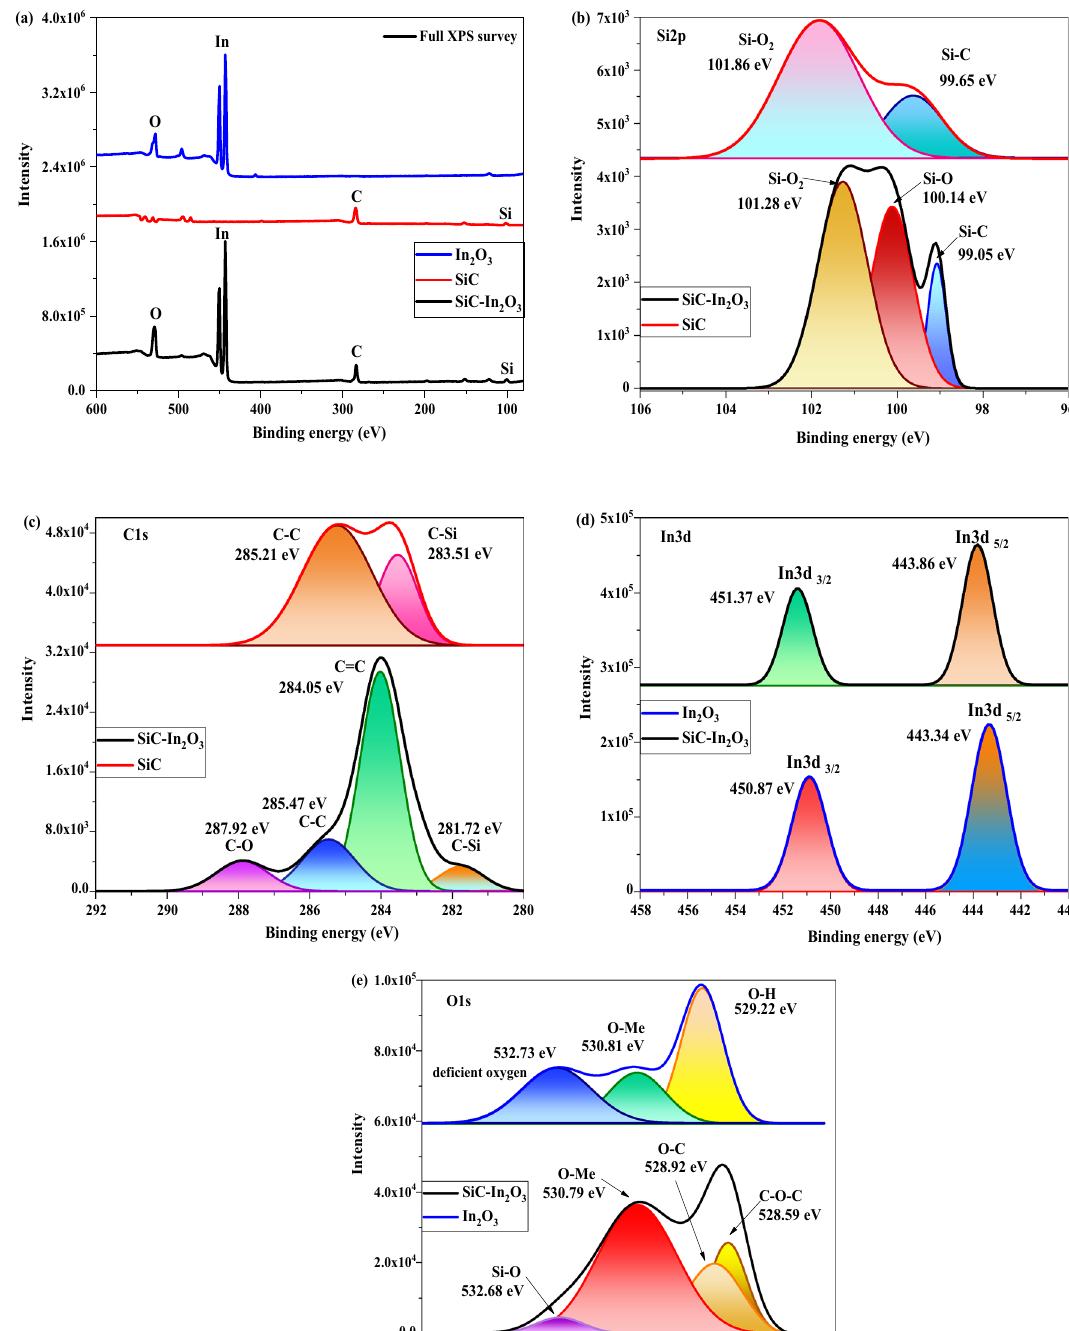
Figure 8. Full XPS surveys of the β-SiC, In 2 O 3 and β-SiC-In 2 O 3 nanocomposite ( a ), Si ( b ), C ( c ), In ( d ) and O ( e